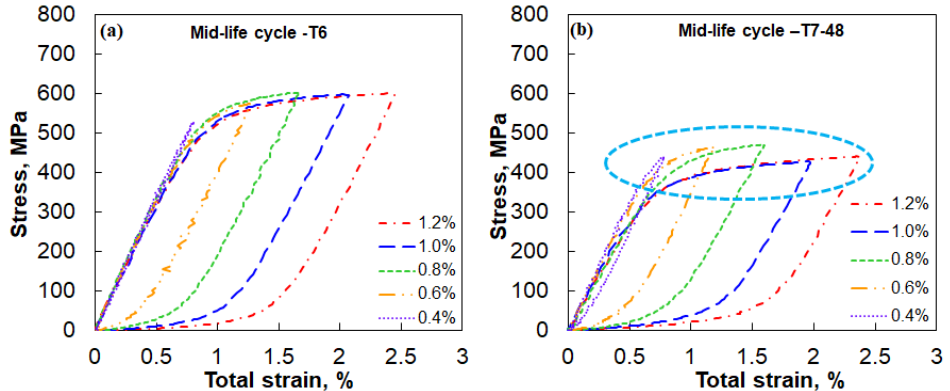
Figure 6. Superimposed stress-strain hysteresis loops with matched lower tips in the mid-life cycle at various total strain amplitudes: ( a ) T6 and ( b ) T7-48 conditions.